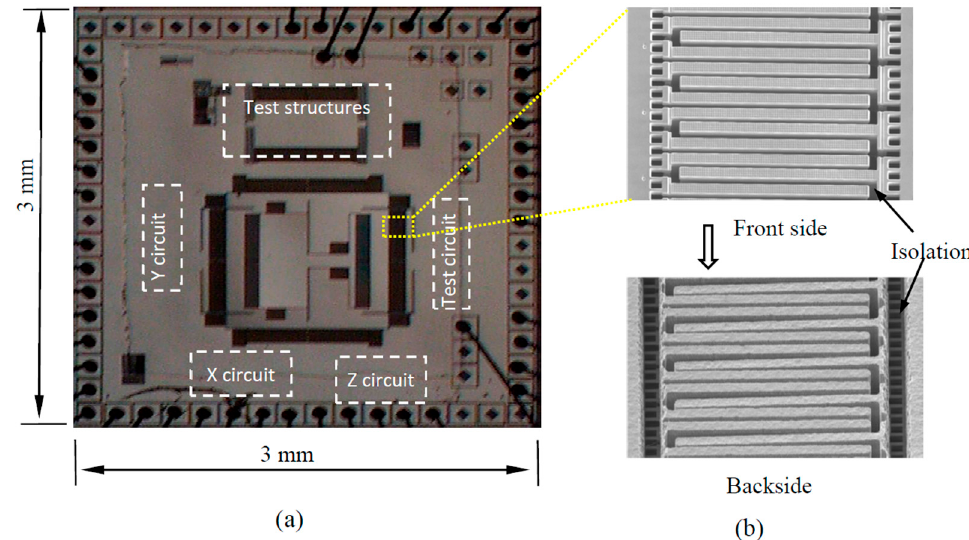
Figure 11. Die photo ( a ) and SEM micrograph of microstructures in the sensor ( b ) reported in [76].